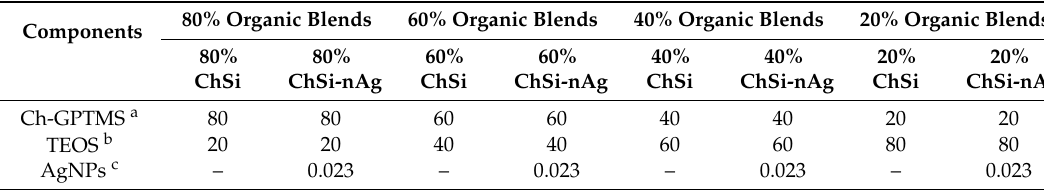
Table 1. Composition of hybrid